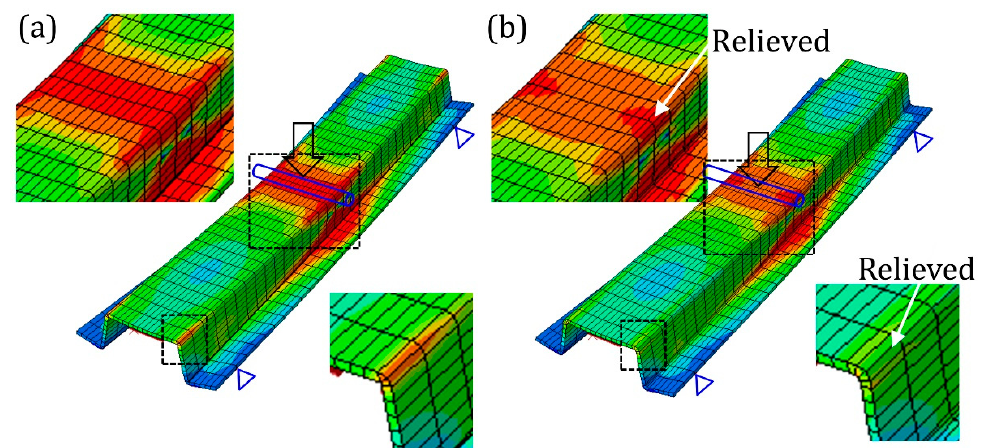
Figure 1. Stress concentration around corners of components produced by sheet metal forming by action of external force and relief by local thickening of corners for ( a ) uniform thickness and ( b ) corner thickening of 30%.